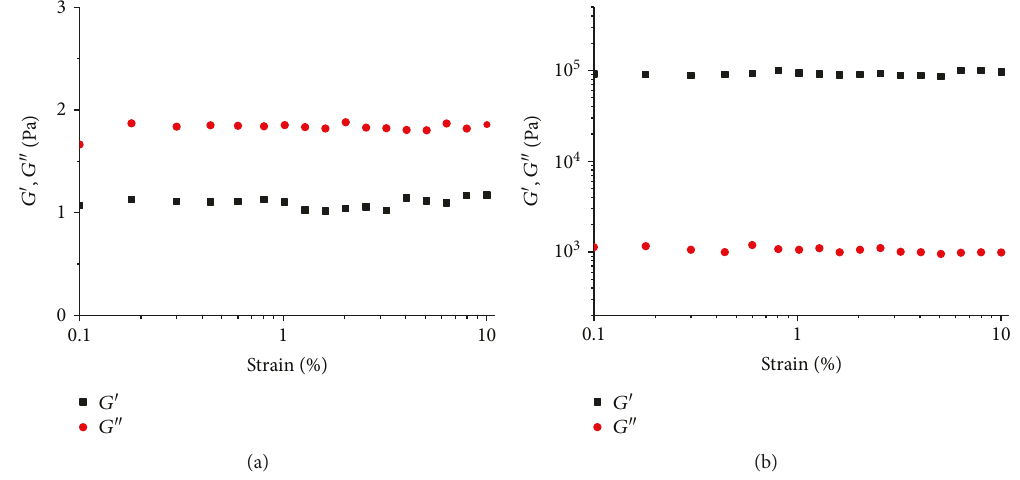
Figure 1: Strain sweep for the polythiourethane system at (a) 25 ° C and (b) 120 ° C. The frequency ω was set at 6.28rads -1